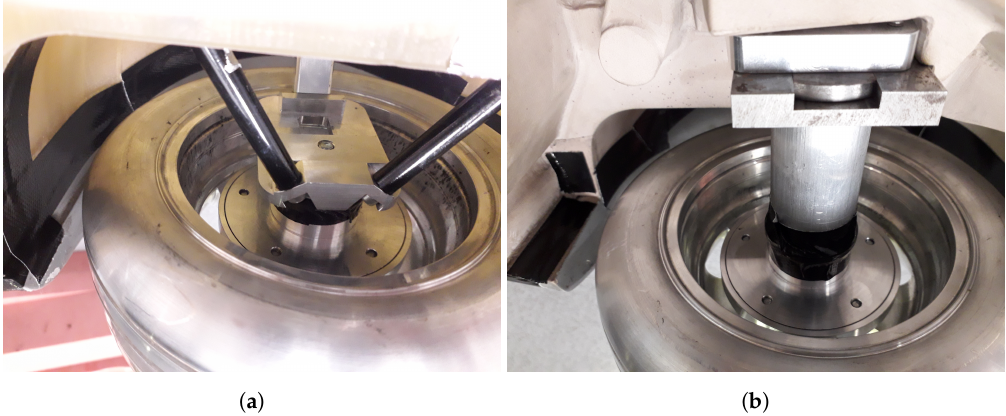
Figure 2. Images of the components used to mount the wheels to the model, at the front ( a ) and, rear ( b ).